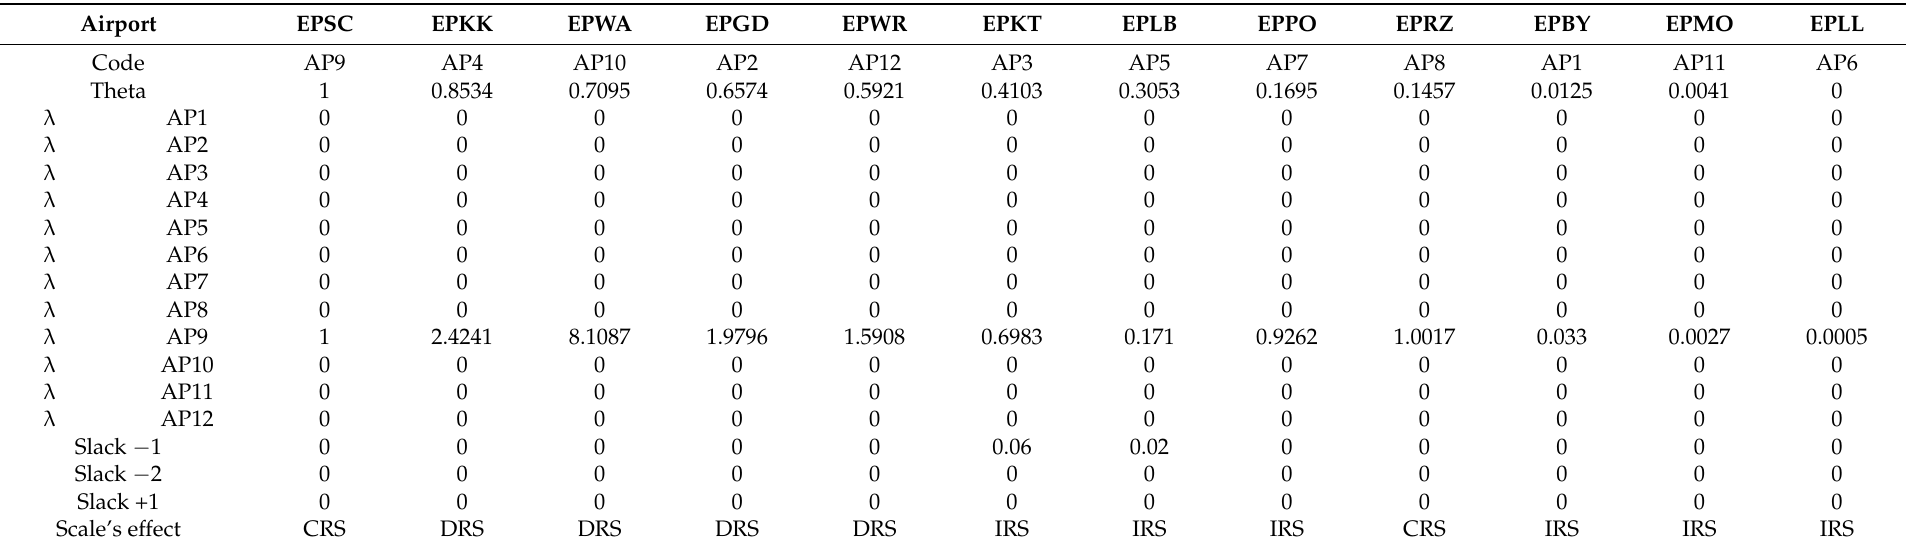
Table A1. Full data envelopment analysis (DEA) results for Polish airports ( λ means